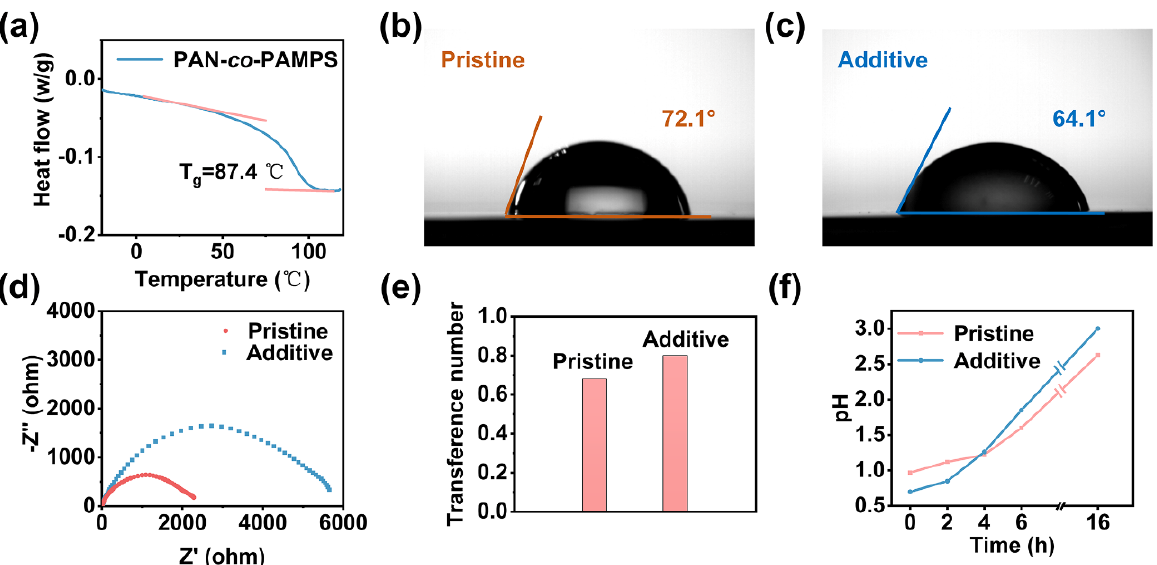
Figure 2. Physicochemical properties of electrolyte. ( a ) DSC of PAN- co -PAMPS. ( b , c ) Contact angles between pristine electrolyte and additive-containing electrolyte at 5 min. ( d ) Charge transfer resistance of Zn|Zn symmetric cell with pristine electrolyte and additive-containing electrolyte. ( e ) Transference number of Zn|Zn symmetric cells with pristine electrolyte and additive-containing electrolyte. ( f ) pH value changes of pristine and additive-containing electrolyte with soaked Zn metal.